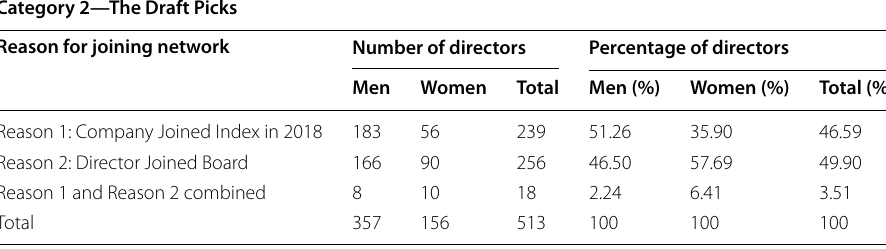
“Reason 1 and Reason 2 combined” indicate that a director had multiple positions and she/he joined the network because the company entered the ASX200 index in 2018 and she/he also joined the board of the company that was already in ASX200